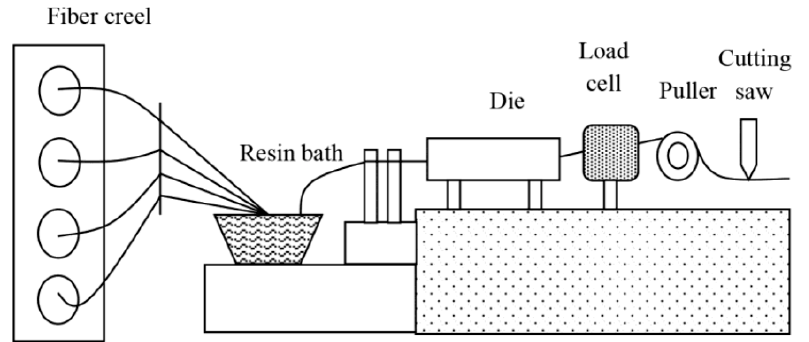
Figure 28. Schematic diagram of a pultrusion process line (reproduced with permission from [354]; copyright© 2021 Taylor & Francis).